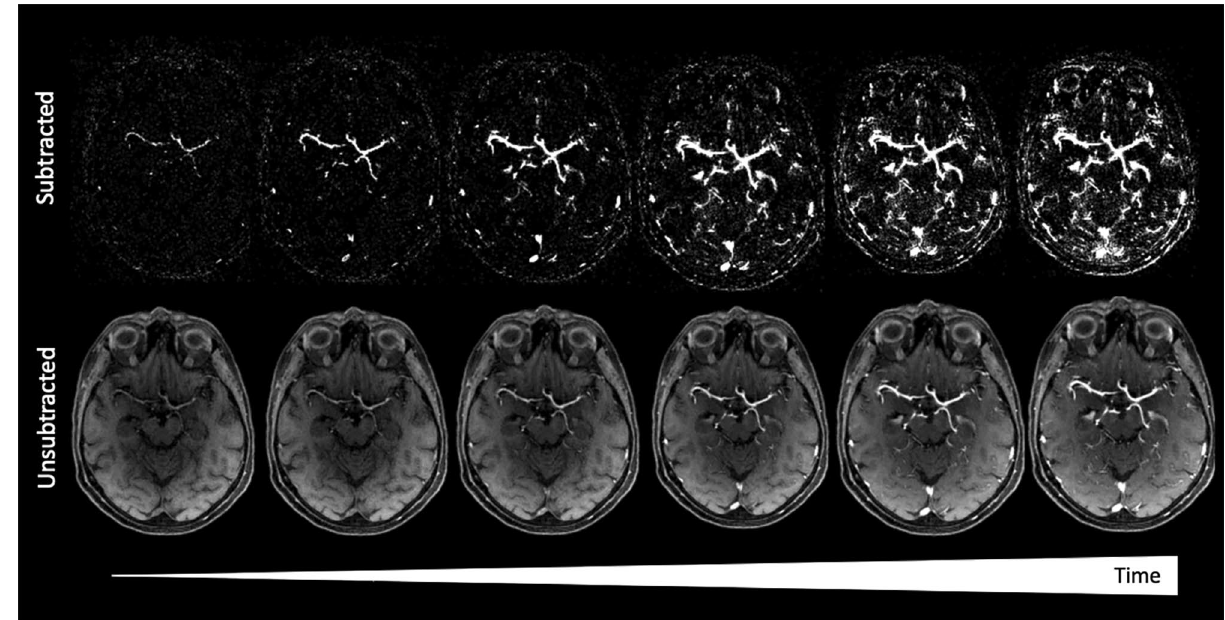
Figure 1. GRASP MRI from a 63-year-old woman imaged for headache reconstructed as time-resolved MRA images. Paired subtracted (top row) and source (bottom row) axial slices obtained from the 3D GRASP imaging volume at the level of the Sylvia cistern and fissure. Dynamic structural images reconstructed from 5 spokes of a golden-angle radial acquisition are shown, demonstrating the earliest arterial through the venous phases of gadolinium bolus